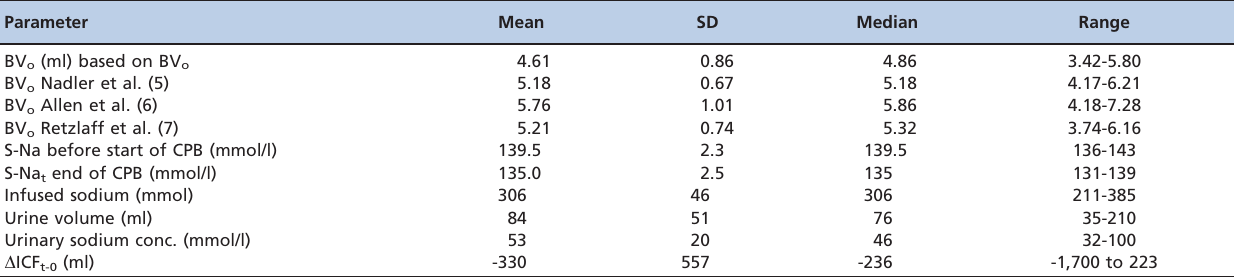
Table 2 - Blood volume estimated by the absolute dilution method (BV o ) and by anthropometric equations (top); fluid balance and calculation of fluid distribution